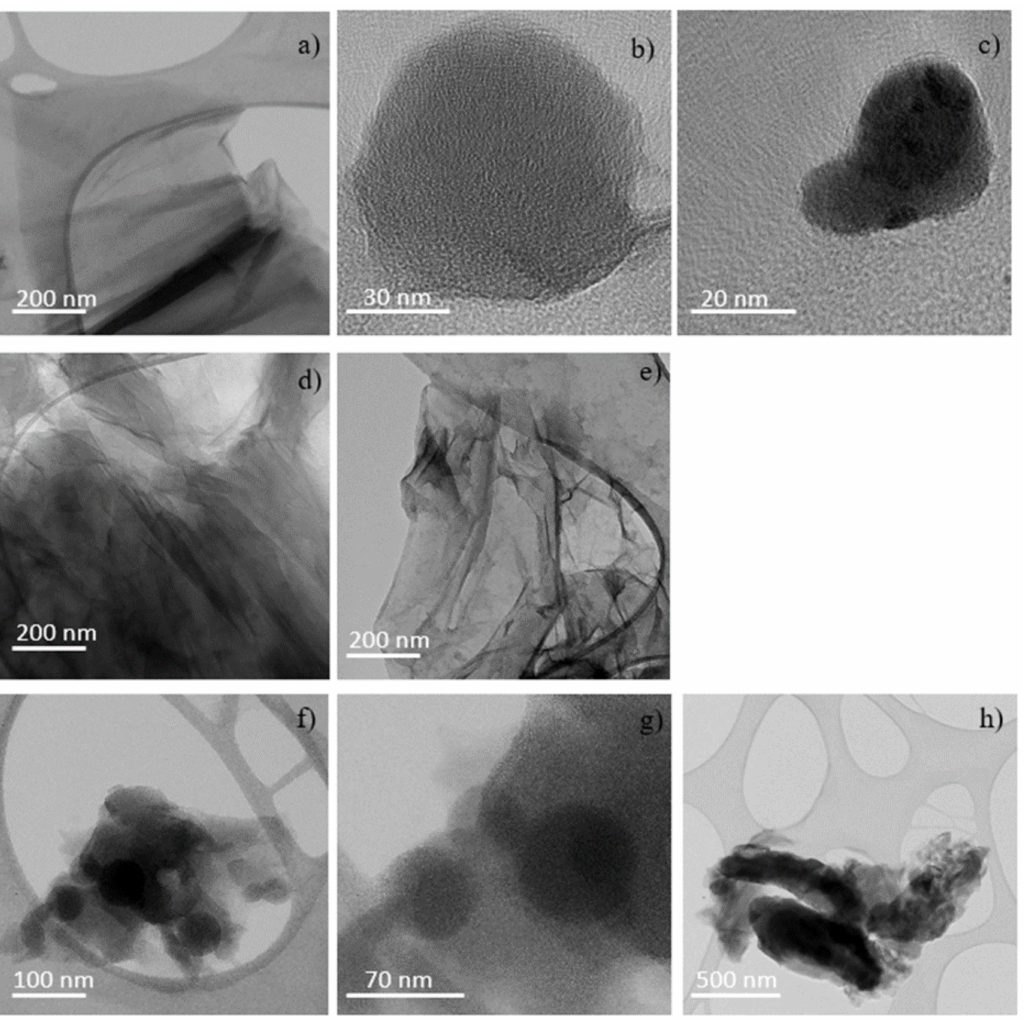
Figure 10. TEM micrograph of GO irradiated by the 3 MeV H + ions at the 5 × 10 11 ions/cm 2 ( a – c ), 5 × 10 12 ions/cm 2 ( d , e ) and 5 × 10 13 ions/cm 2 ( f – h )